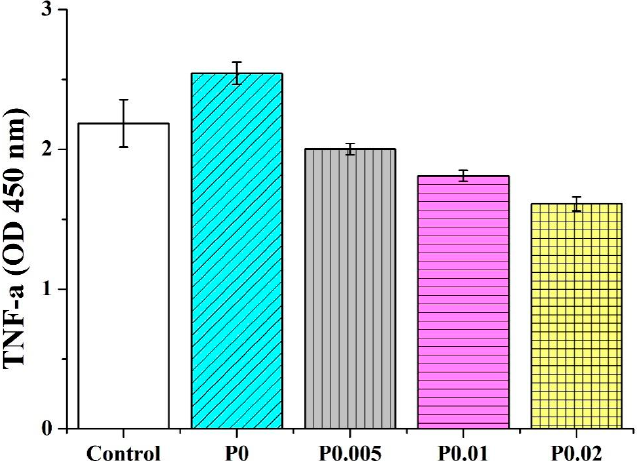
Figure 11. TNF- α inflammatory factor of nanofiber membranes as related to the P. emblica content.